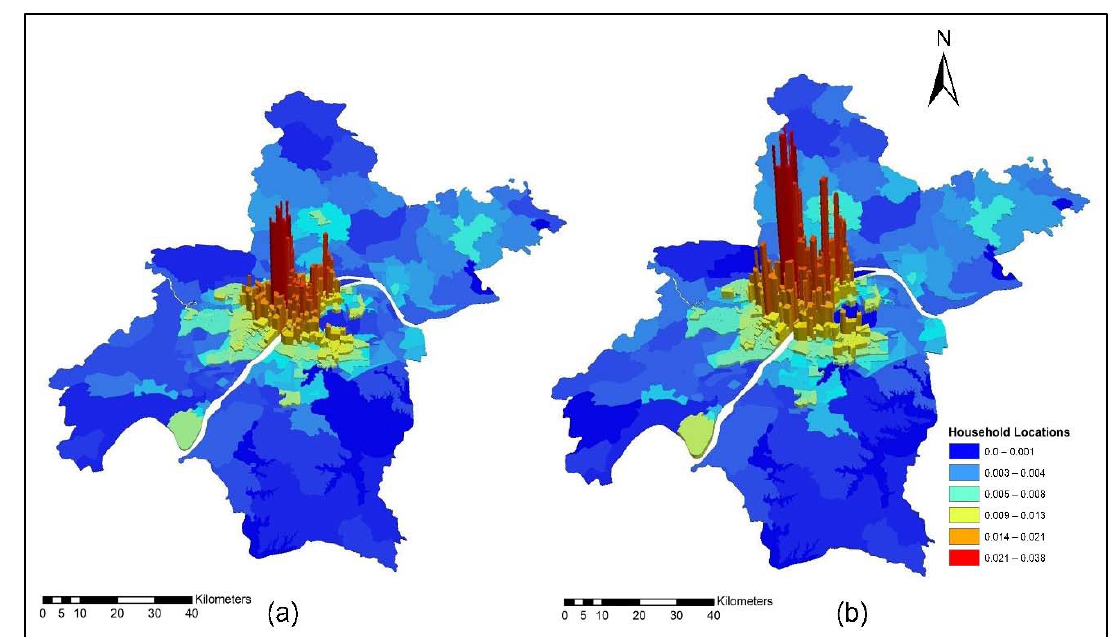
Figure 13. ( a , b ) ISE-estimated household locations: ( a ) during evening peak for the year 2012; ( b ) during evening peak for the year 2015.